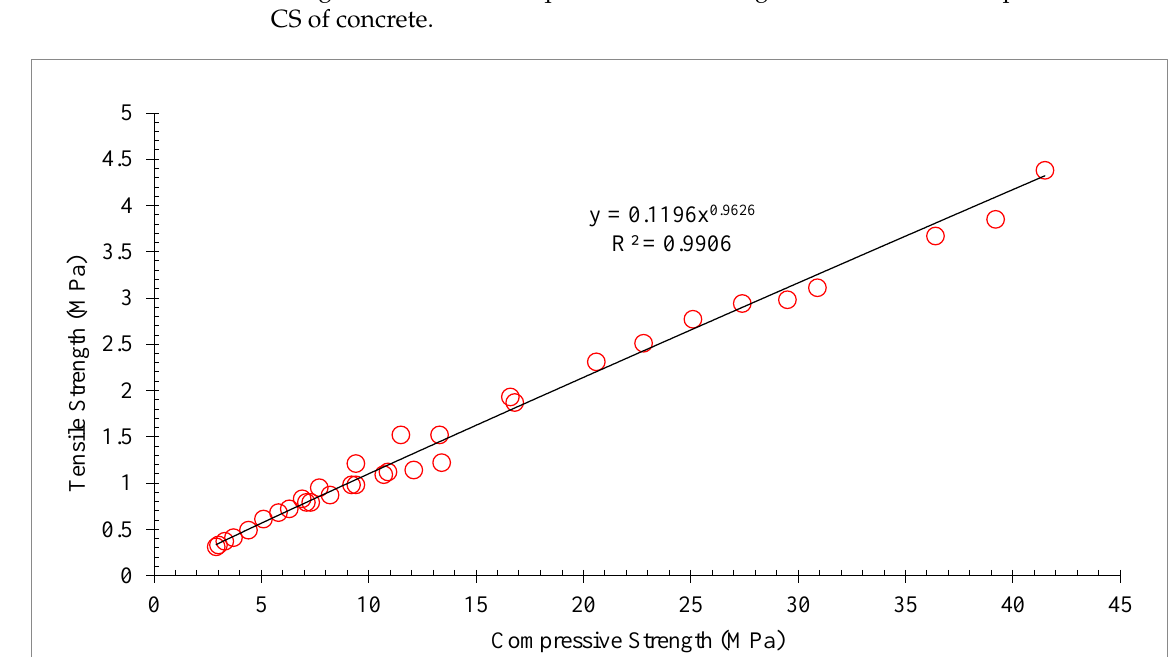
Figure 11. Correlation between compressive and tensile strength: data source [30].